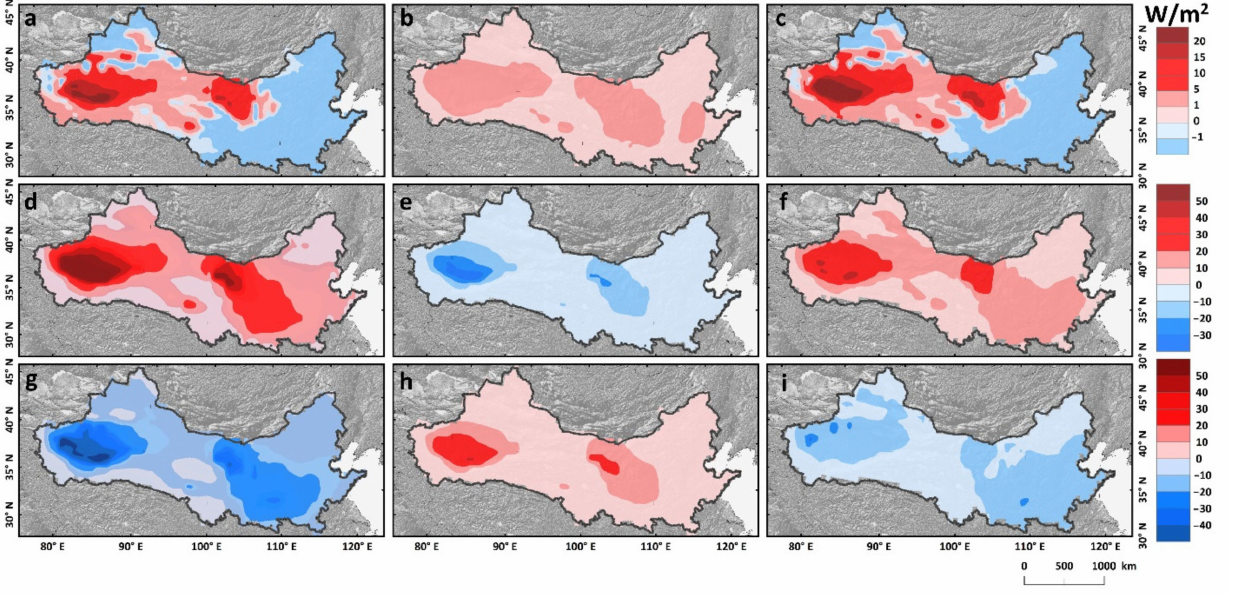
Figure A4. Average dust aerosol radiative forcing in spring. ( a ) Shortwave radiative forcing at the top of the atmosphere; ( b ) longwave radiative forcing at the top of the atmosphere; ( c ) net radiative forcing at the top of the atmosphere; ( d ) short- wave radiative forcing in the atmosphere; ( e ) longwave radiative forcing in the atmosphere; ( f ) atmospheric net radiative forcing; ( g ) surface shortwave radiative forcing; ( h ) surface longwave radiative forcing; ( i ) surface net radiative